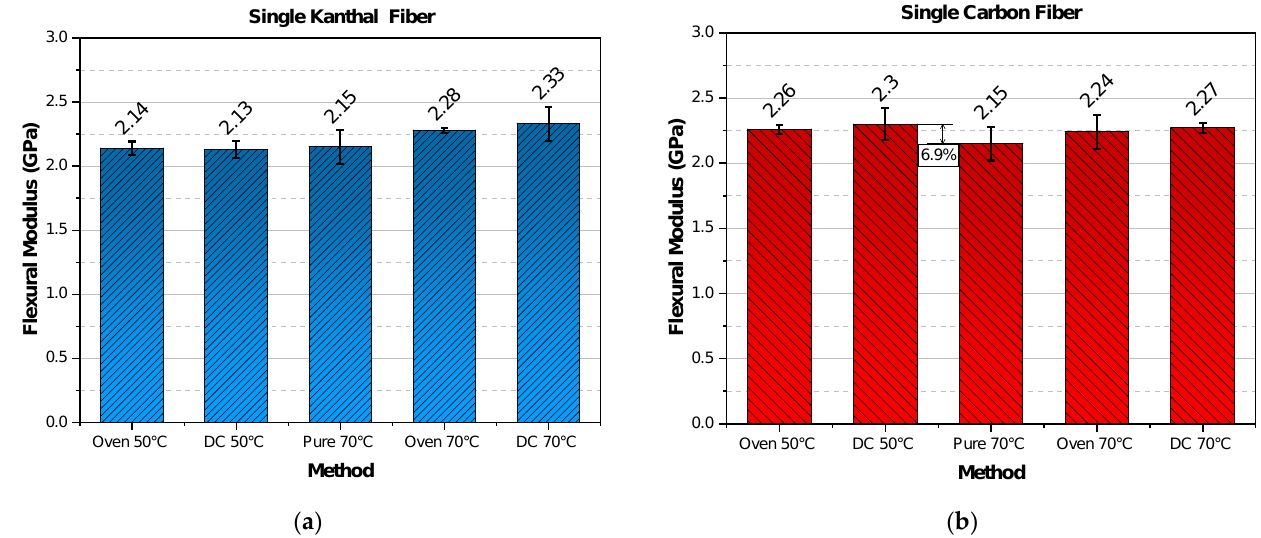
Figure 2. Flexural modulus versus curing method for ( a ) single Kanthal fiber specimens and ( b ) single carbon fiber specimens.